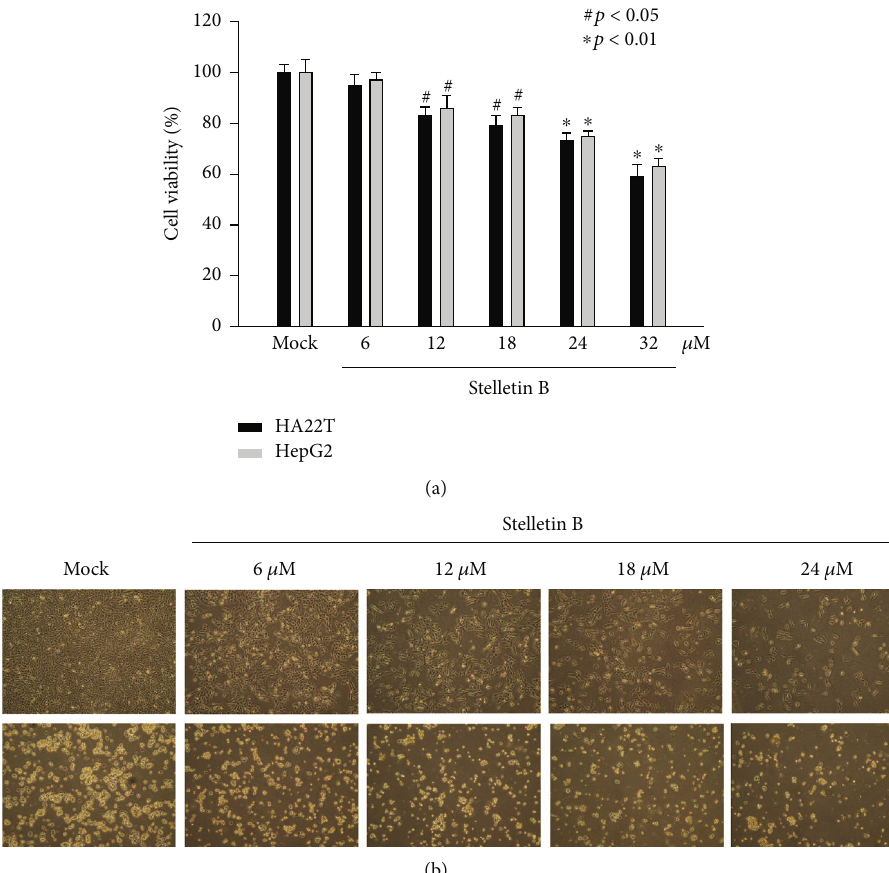
Figure 2: Cytotoxic e ff ects of Stellettin B on HA22T and HepG2 cells. (a) Investigation of the cytotoxic e ff ects of Stellettin B on human hepatoma cell lines. HA22T and HepG2 cells were treated with Stellettin B at concentrations of 6, 12, 18, 24, and 32 μ M for 24h, and an MTT assay was employed to examine the cell viability. The results shown here are representative of three independent experiments ( # p < 0 : 05 ; ∗ p < 0 : 01 ). (b) E ff ect of Stellettin B on the morphological changes of HA22T and HepG2 cells treated with Stellettin B at concentrations of 6, 12, 18, and 24 μ M for 24 h. ( 100 × magnification